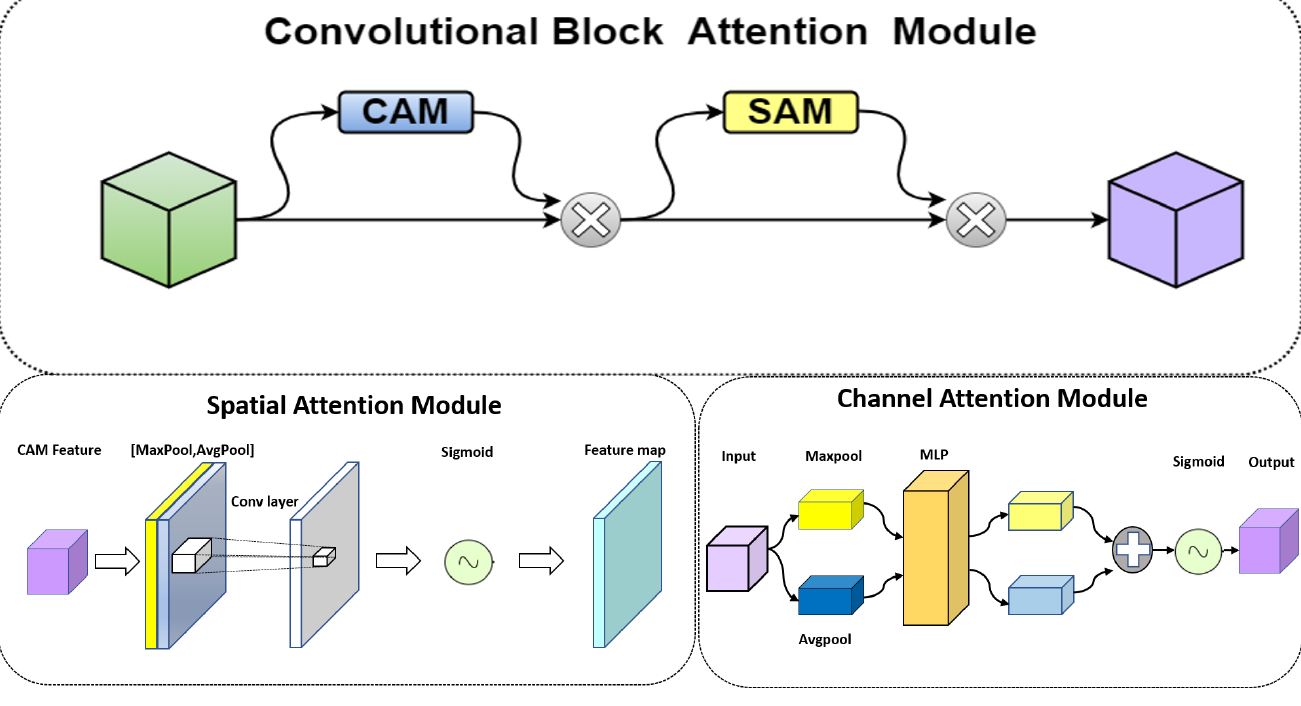
Figure 6. CBAM structure.